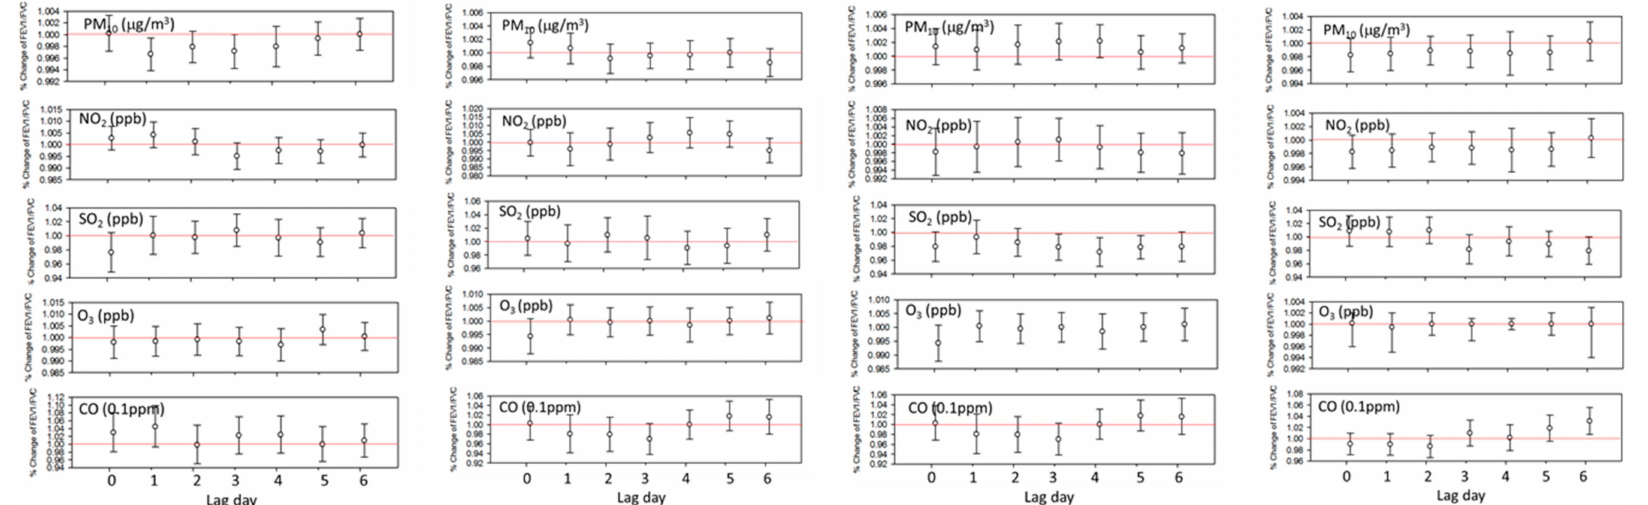
Figure 3. Association of FEV 1 /FVC variation with exposure level to air pollution in neversmoking patients—spring, summer, fall, winter. Results were adjusted for meteorological condition, sex, age at the first pulmonary function test (PFT) and Total_IgE